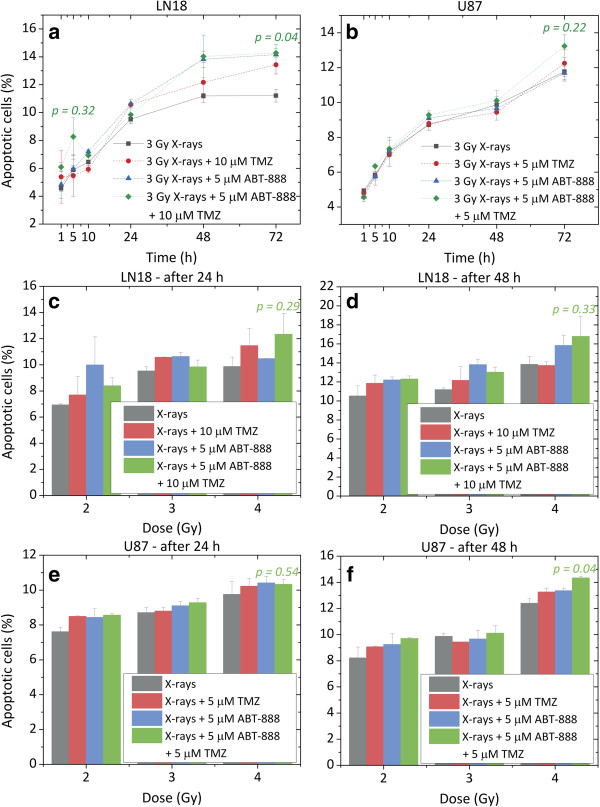
Percentages of apoptotic cells in MGMT-unmethylated LN18 (a) and MGMT-methylated U87 cells (b) up to 72 h after irradiation. Cells were exposed for 5 h to 5 μM ABT-888 before being treated with 5 (b) or 10 (a) μM TMZ for 2 h and irradiated with 3 Gy X-rays. Dose–response percentages of apoptotic cells in MGMT-unmethylated LN18 (c, d) and MGMT-methylated U87 cells (e, f). Cells were exposed to 2, 3 and 4 Gy X-rays and fixed at 24 and 48 h after irradiation. Error bars indicate the standard error of two independent experiments. Please note the scale change on the Y-axis of the graphs. P values relatively to the control are also shown.